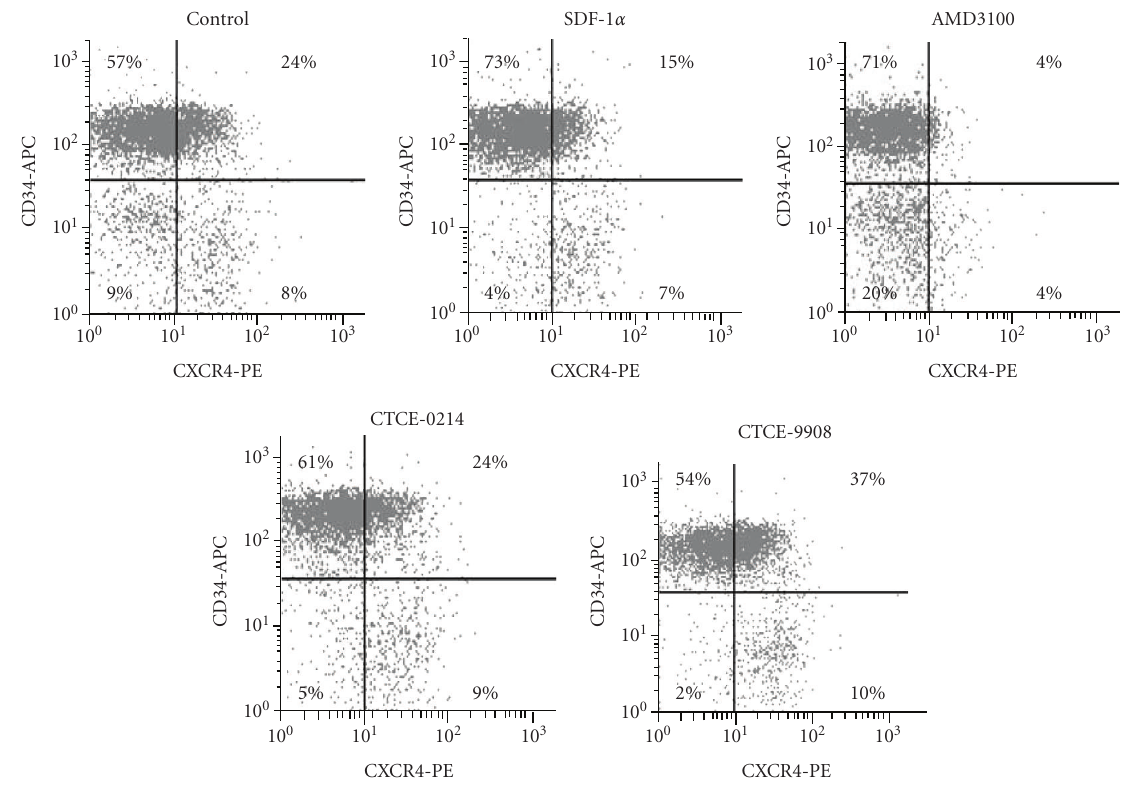
Figure 5: E ff ects on surface levels of CXCR4 detected by flow cytometry. Surface expression of CXCR4 (phycoerythrin; PE) and CD34 (allophycocyanin, APC) was analyzed on the surface of CD34 + enriched cells upon treatment with CXCR4 agonist and antagonist without additional washing steps. Demarcation of autofluorescence is indicated by black lines. The proportion of CXCR4 + cells was higher in residual CD34 − cells compared to the CD34 + fraction. CXCR4 detection was reduced upon treatment with SDF-1 α and AMD3100. The peptide agonist CTCE-0214 did not a ff ect the proportion of CXCR4 + cells, whereas the peptide antagonist CTCE-9908 increased this proportion. Concentration of cytokines was 500 ng/mL. Representative plots of four independent experiments are